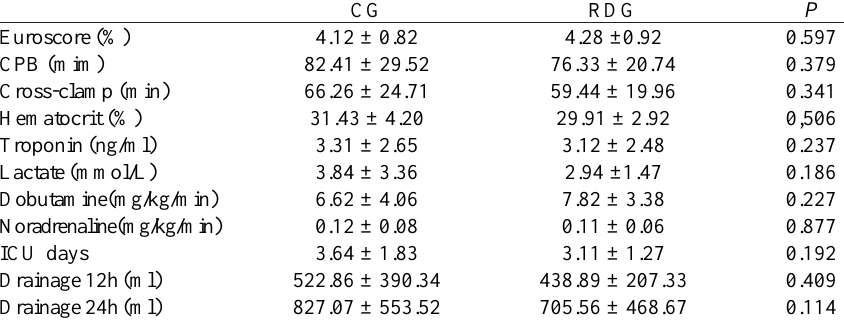
Table 2. Surgical